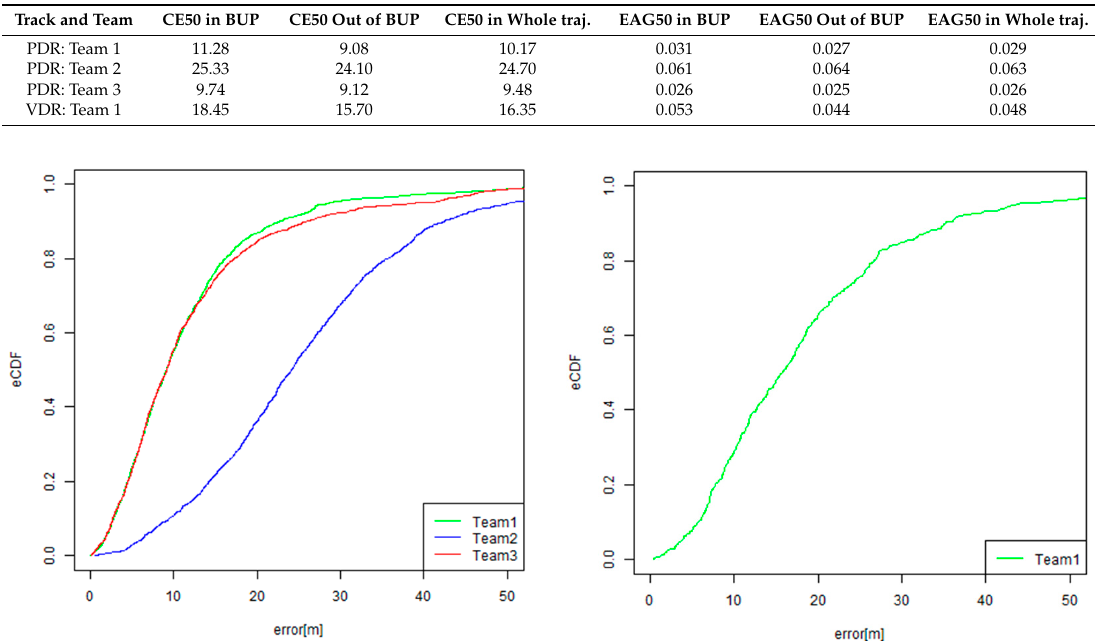
Table 7. Comparison of the CE50 and EAG50 values in/out of BUP.